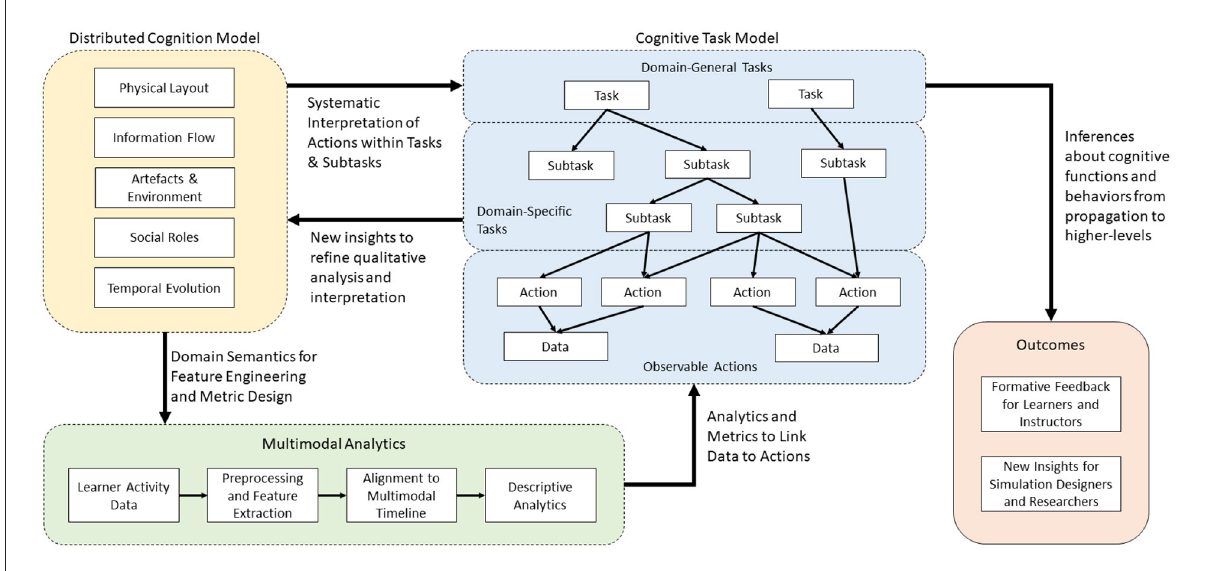
FIGURE2 The overall theoretical framework to combine qualitative DiCoT analysis with quantitative multimodal analytics for understanding learner behaviors in simulation-based